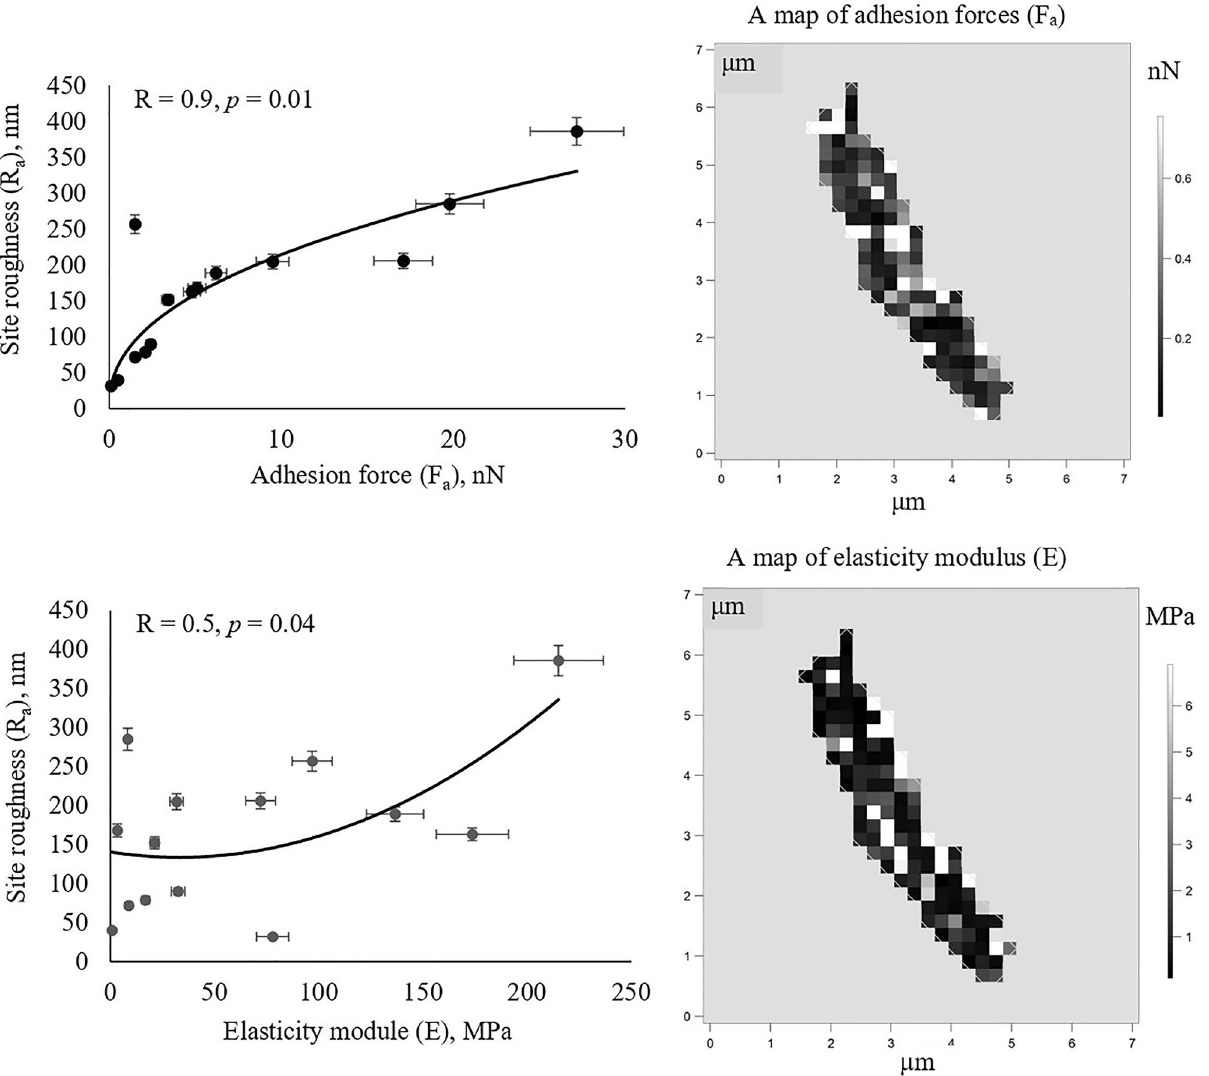
Figure 6. Correlations between nanomechanical parameters (F a , E) and roughness (R a ) of specific cell surface areas, and maps of F a and E distribution values on the cell surface of R. opacus IEGM 262. White pixels correspond to cell surface appendages, which are proposed to be specific cytoadhesive structures of Rhodococcus